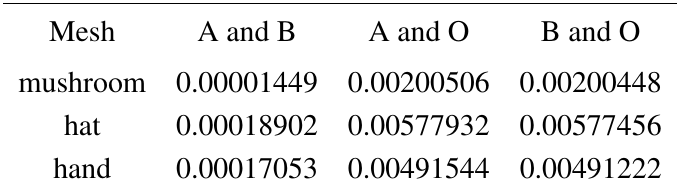
Table 5. The test results of performing polar subdivision wavelet transforms in different orders. For simple, we name the resulted meshes by performing analysis in radial layers first as A; the resulted meshes by performing analysis in circular layer first as B; O means original unperturbed meshes. The table lists the L error between any two of 2